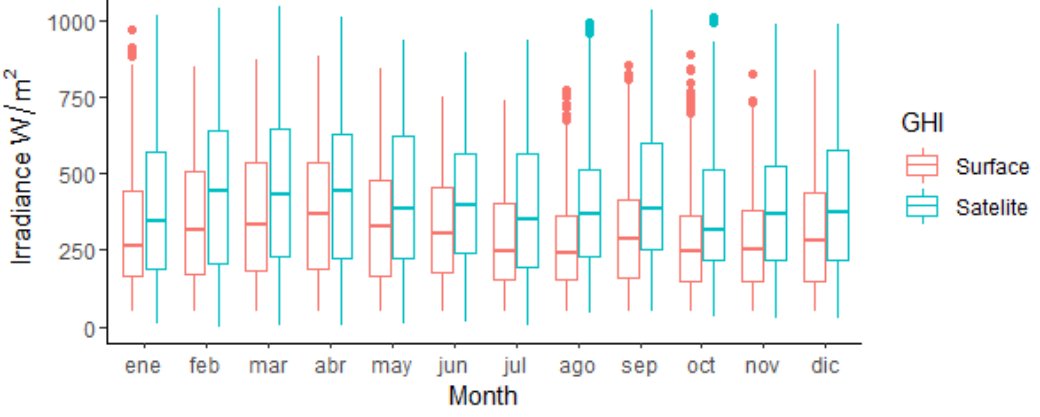
Figure 9. Comparison boxplot between surface and satellite GHI estimations, hourly profile.